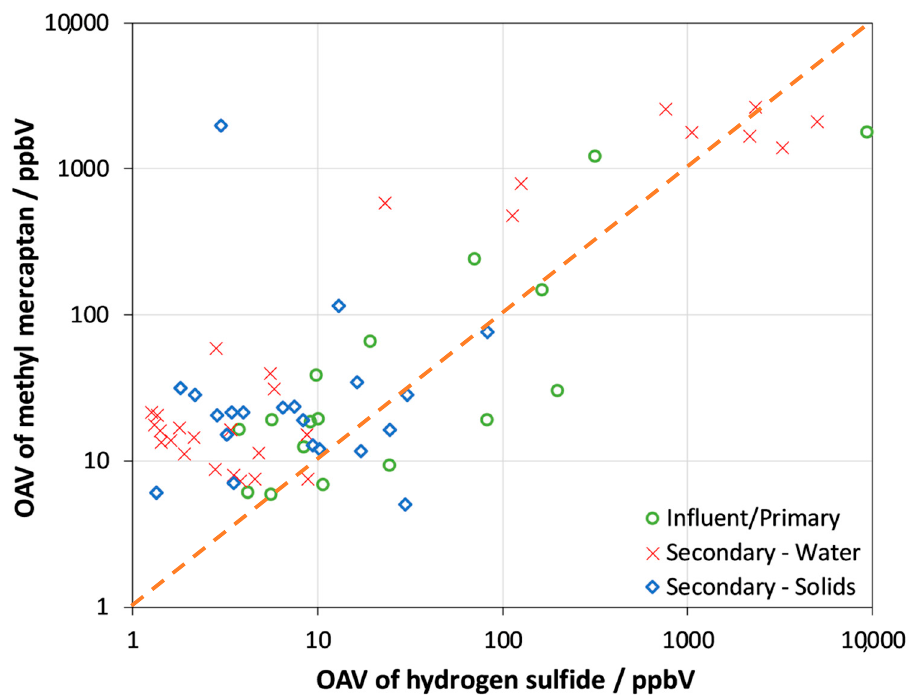
Figure 8. The relationship between the dominant sulfur odorants (hydrogen sulfide and methyl mercaptan) observed in the WWTP using SIFT-MS for the primary (green circles), secondary water (red crosses), and secondary solids (blue diamonds) odor sources. Note the logarithmic axes.